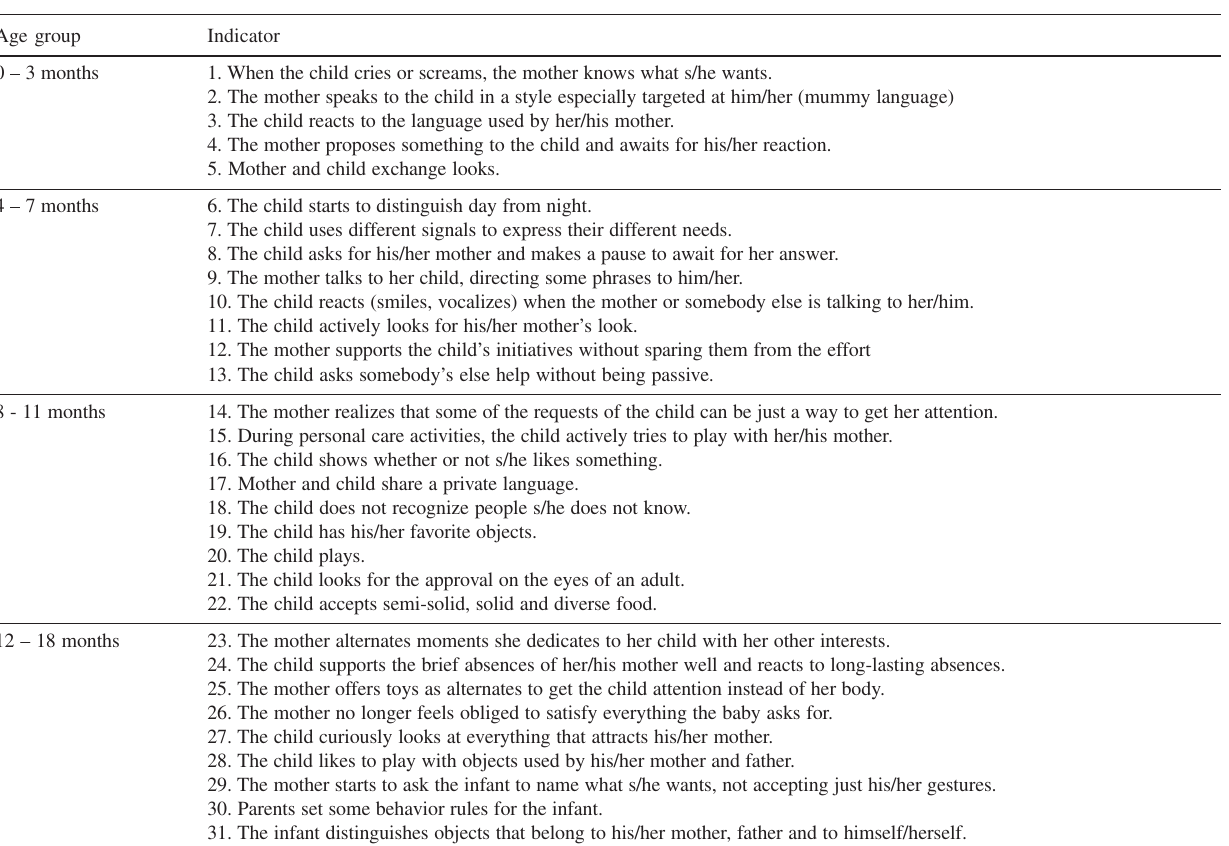
Table 2 - List of 31 Clinical Indicators of Risk for Child Development.